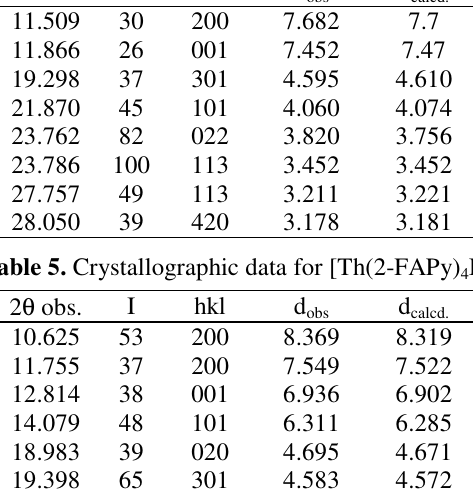
Table 4. Crystallographic data for [Th(2-FAPy) 2 θ obs.